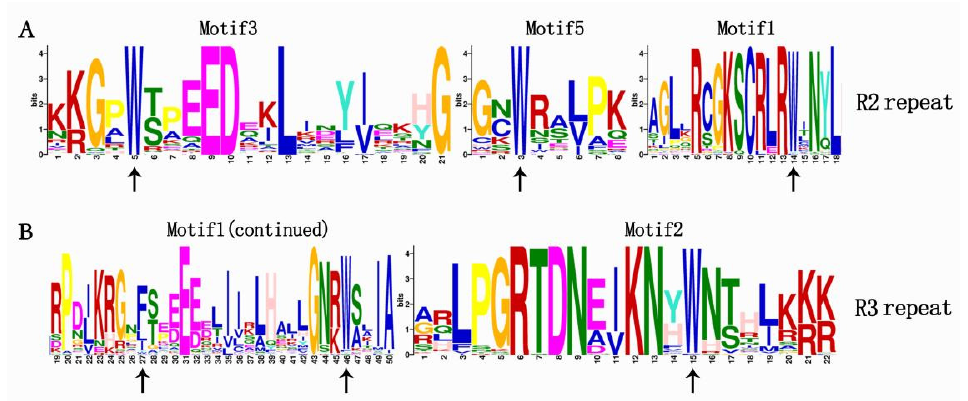
Figure 2. R2 and R3 MYB repeats across 69 R2R3-MYB proteins in C. paliurus . The sequence logos of the R2 ( A ) and R3 ( B ) MYB repeats are based on alignments of 69 C. paliurus R2R3-MYB domains. The bit score represents the information for each position in the sequences. Arrows represents the conserved tryptophan residues in the MYB domain.